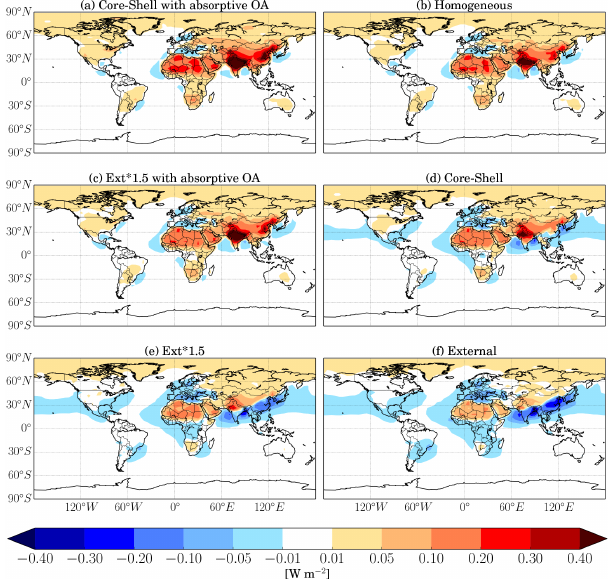
Figure 6. The DRE for the BASE–NOBIOF comparison assuming a core-shell with absorptive (a) OA (mean: 0.021Wm − 2 ), (b) ho- mogeneous (mean: 0.015Wm − 2 ), (c) ext*1.5 with absorptive OA (mean: 0.015Wm − 2 ), (d) core-shell (mean: 0.007Wm − 2 ), (e) ext*1.5 (mean: − 0.002Wm − 2 ), and (f) external (mean: − 0.008Wm − 2 ) mixing